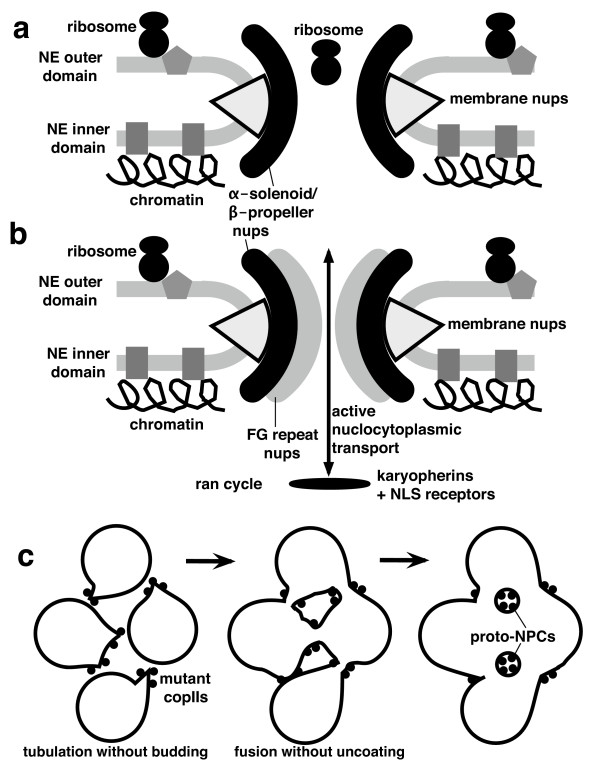
Two-phase origin of the nuclear envelope and trans-envelope transport. (a). Nucleoporins (Nups) forming the octagonal cylindrical scaffold evolved by duplications of coat proteins of COPII secretory vesicles with α-solenoid and/or β-propeller domains, being attached by integral membrane Nups descended from actinobacterial membrane proteins; (b). NPC lumens were narrowed by plugs of FG-repeat-rich Nups, which form a dynamic gel-like meshwork that prevents passive diffusion of macromolecular complexes and mediates active specifically-targeted nucleocytoplasmic exchange by carrier complexes, typically consisting of large karyopherin proteins and their cargo either bound directly or by adaptors. (c). Phase I surface view, showing complete Ran GTPase-mediated fusion of RER cisternae prevented by COPII coat proteins (black blobs) remaining in place to become octagonal NPC scaffolds.